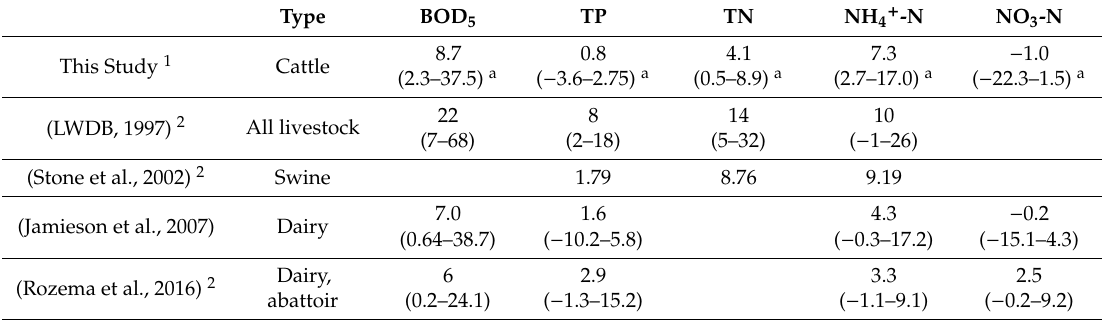
Table 5. Summary of average (and range) of first-order areal kinetic constants, k, (m / yr) for sizing livestock wastewater treatment